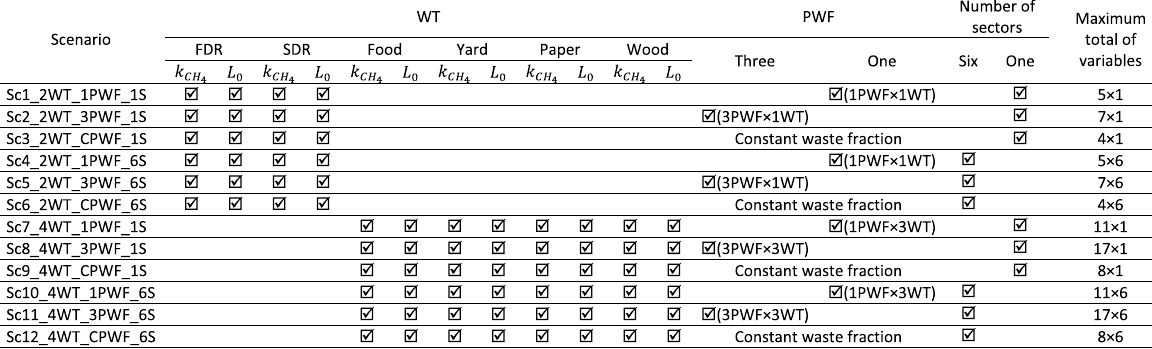
Table 4 CH modeling optimization variables in each optimizing 4